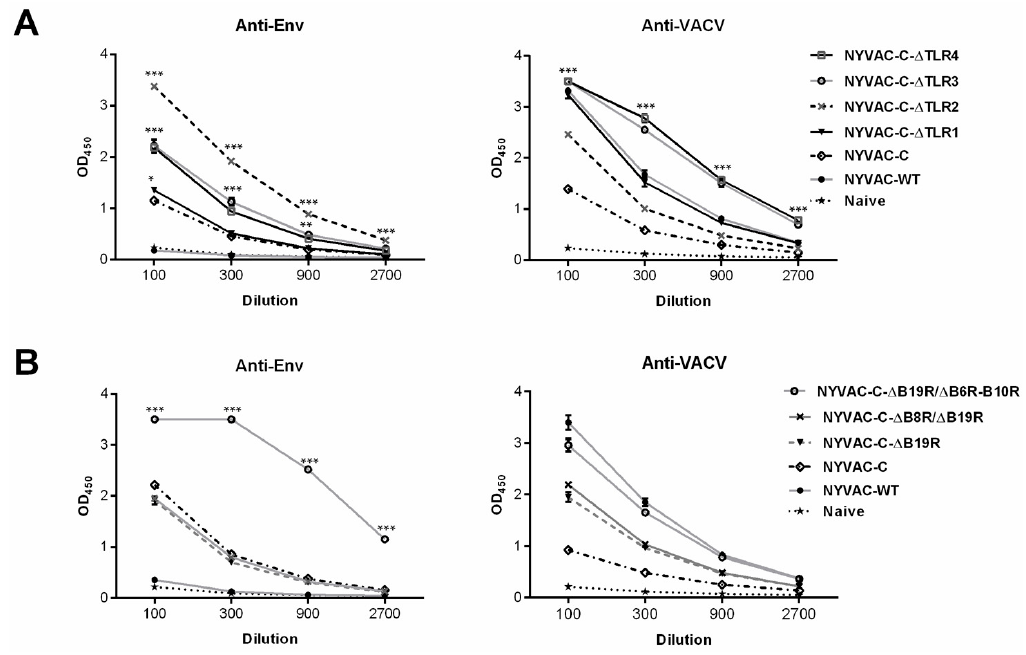
Figure 5. Anti-Env and -VACV humoral responses induced by NYVAC-C recombinants after combined deletion of VACV immunomodulatory genes. ( A ) Humoral responses after sequential deletion of VACV-TLR inhibitors A46R , A52R , K7R and B15R . ( B ) Humoral responses after deletion of several unknown non-essential genes in combination with VACV-IFN and cytokine inhibitors. ELISA assessment of levels of IgG antibodies to Env and vaccinia virus proteins in serum from naïve and immunized mice. Data shown as mean OD 450 ± SD for each group at the dilutions assayed. * p < 0.05, ** p < 0.005, *** p < 0.001. Significant differences compared to the NYVAC-C group (anti-Env response, left) or the NYVAC-WT group (anti-VACV,